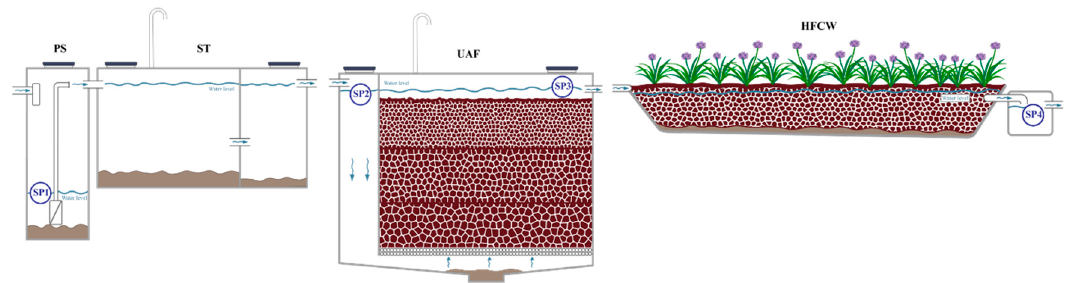
Figure 2. Main parts of the wastewater treatment plant. The four sampling points (SP1, SP2, SP3, and SP4) are circled in